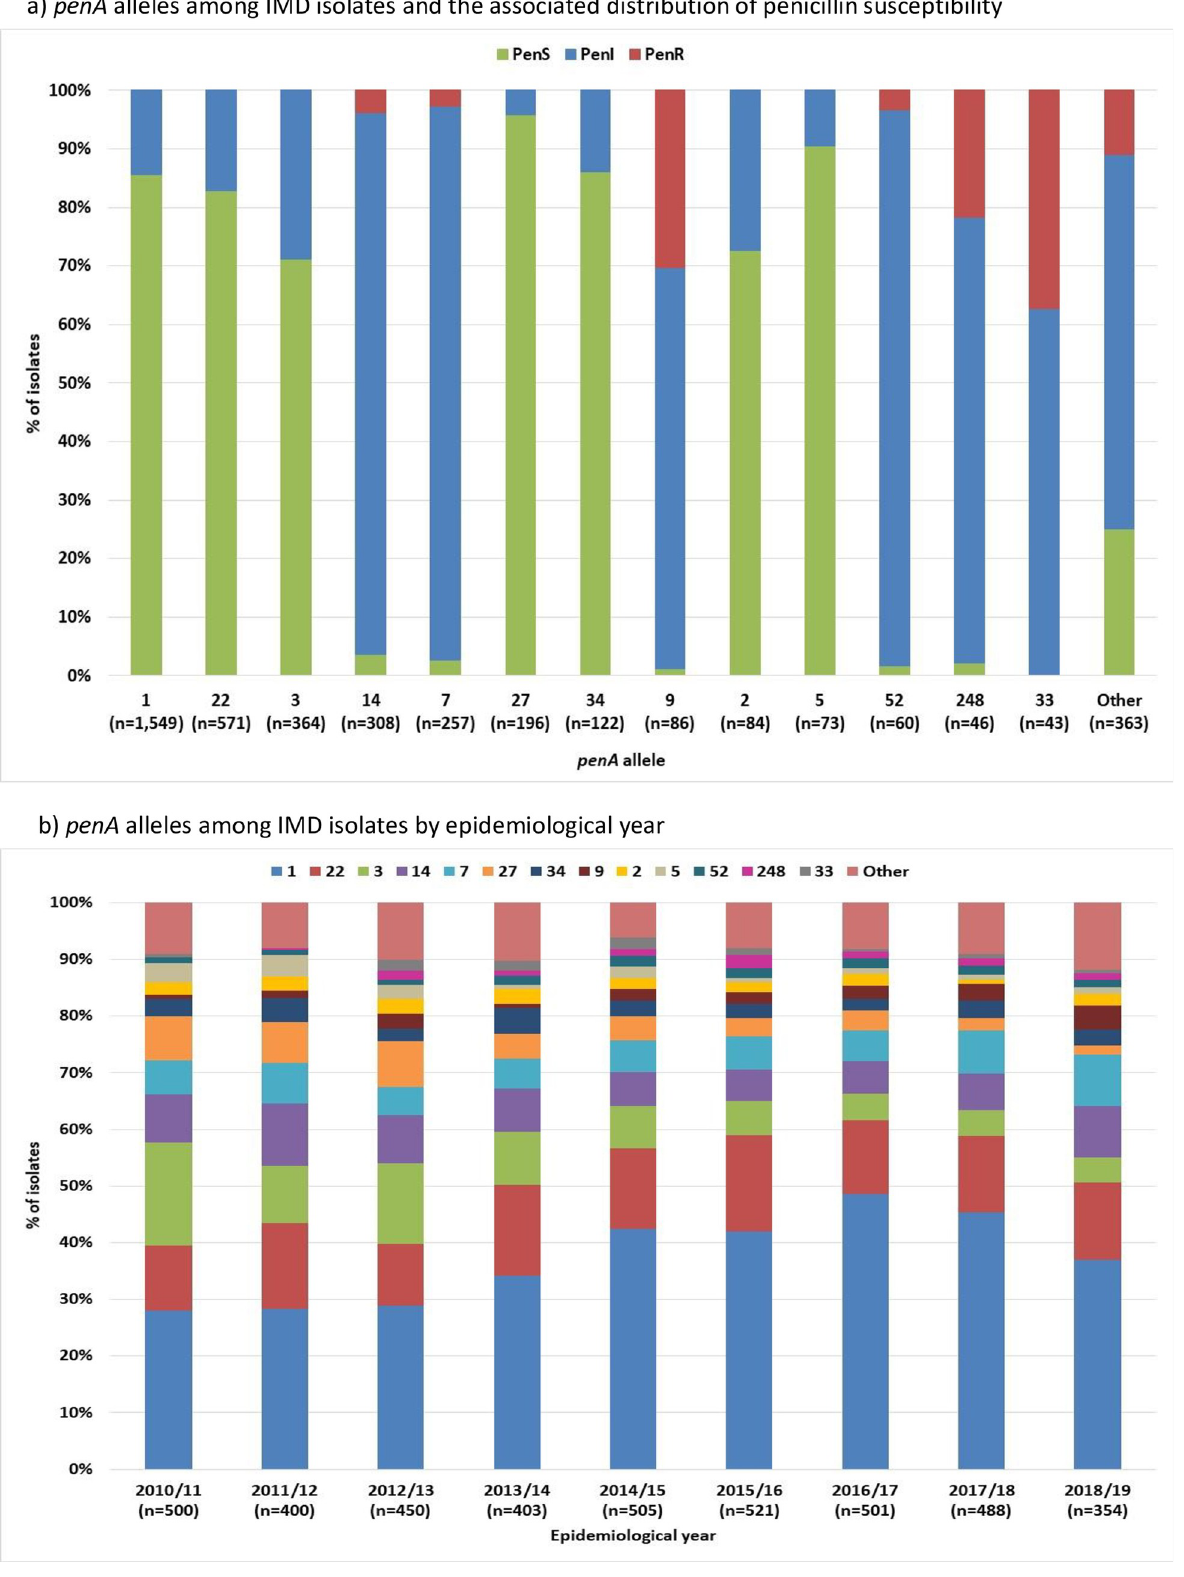
Fig 2. penA alleles among IMD isolates in England, Wales and Northern Ireland 2010/11 to 2018/19. https://doi.org/10.1371/journal.pone.0260677.g002 PLOS ONE | https://doi.org/10.1371/journal.pone.0260677 November29,